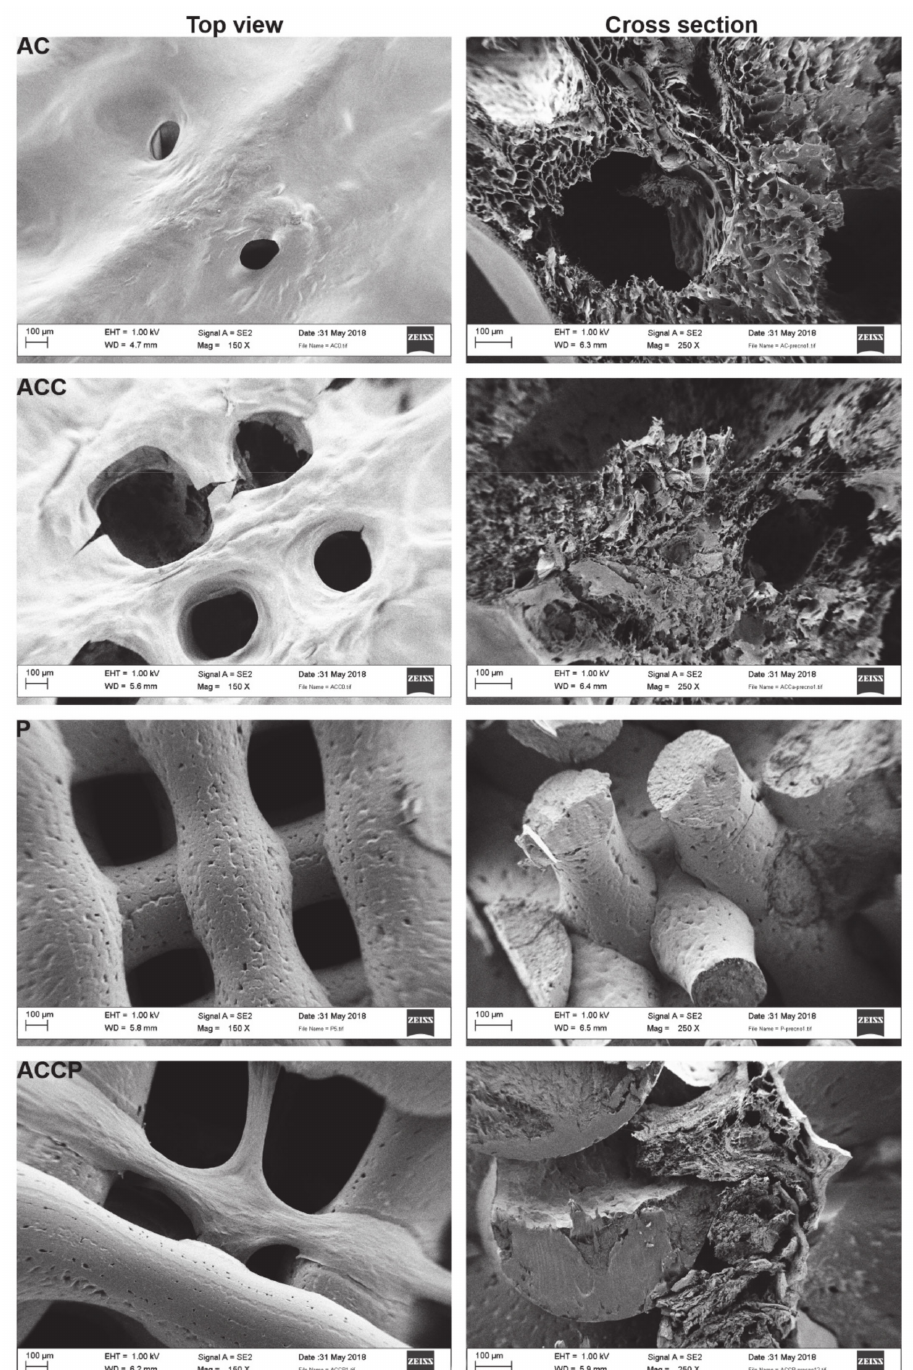
Figure 3. SEM images of the 3D printed